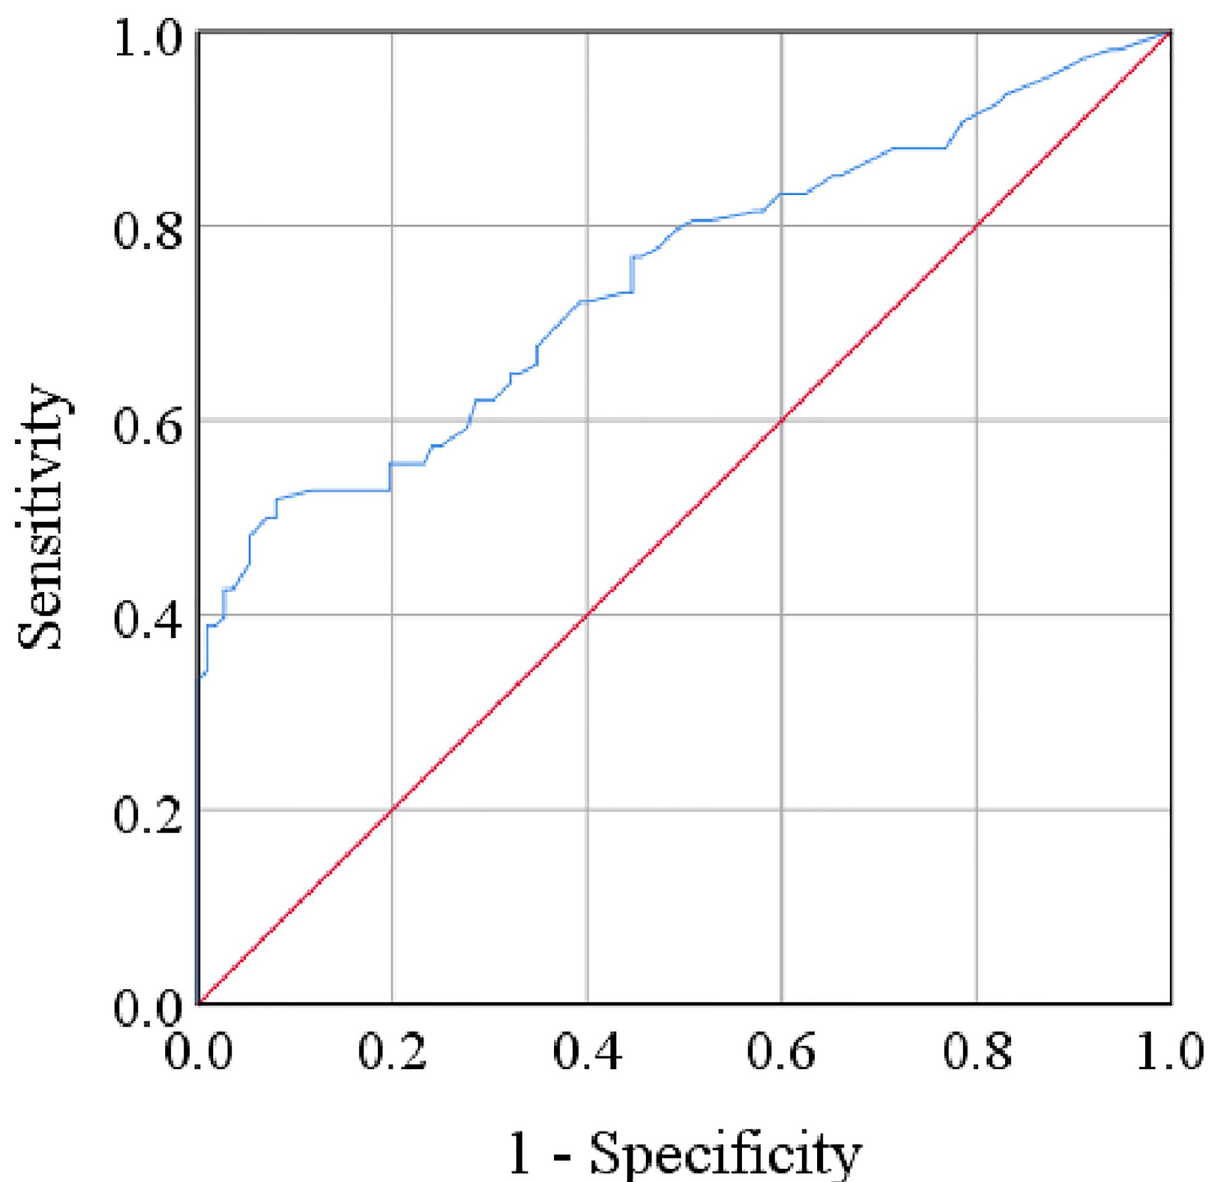
Fig 3. Receiver operating characteristic (ROC) curve for serum resistin. The cut-off point was detected as 6.39 ng/mL.